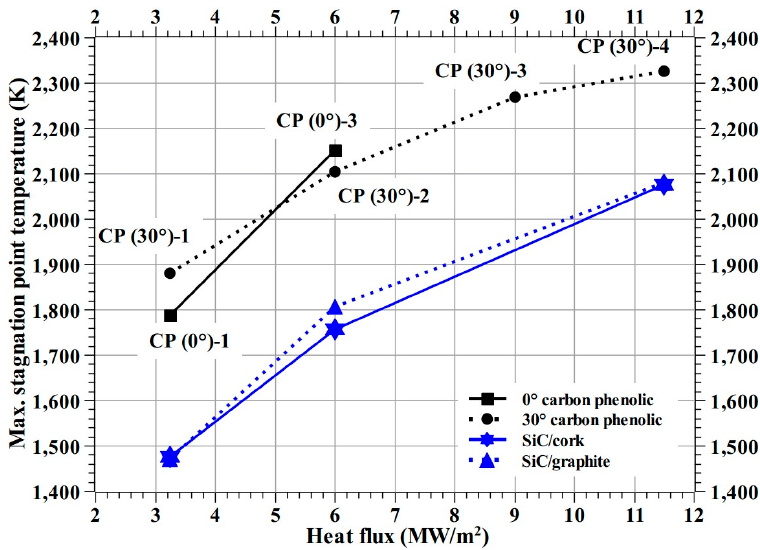
Figure 24. Maximum stagnation point temperature vs. heat flux.